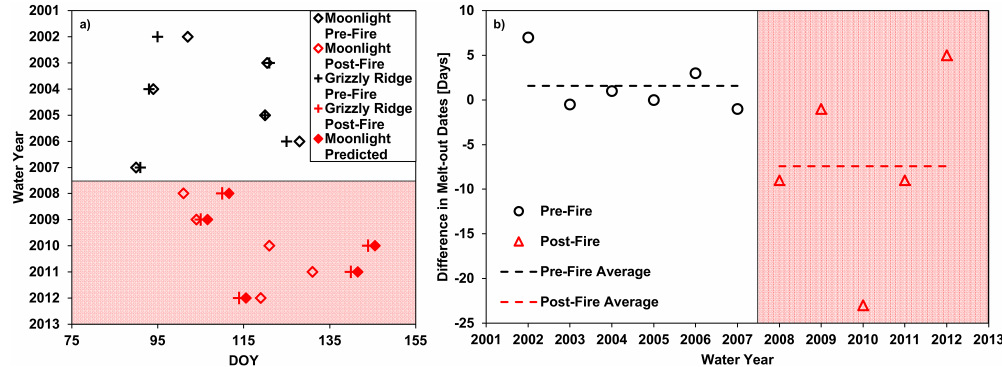
Figure 8. Basin-averaged snow cover melt-out dates for the area of the Moonlight Fire and Grizzly Ridge (a) . Relative difference in melt-out dates (Moonlight Fire area–Grizzly Ridge) from the area of the Moonlight Fire and Grizzly Ridge (b)